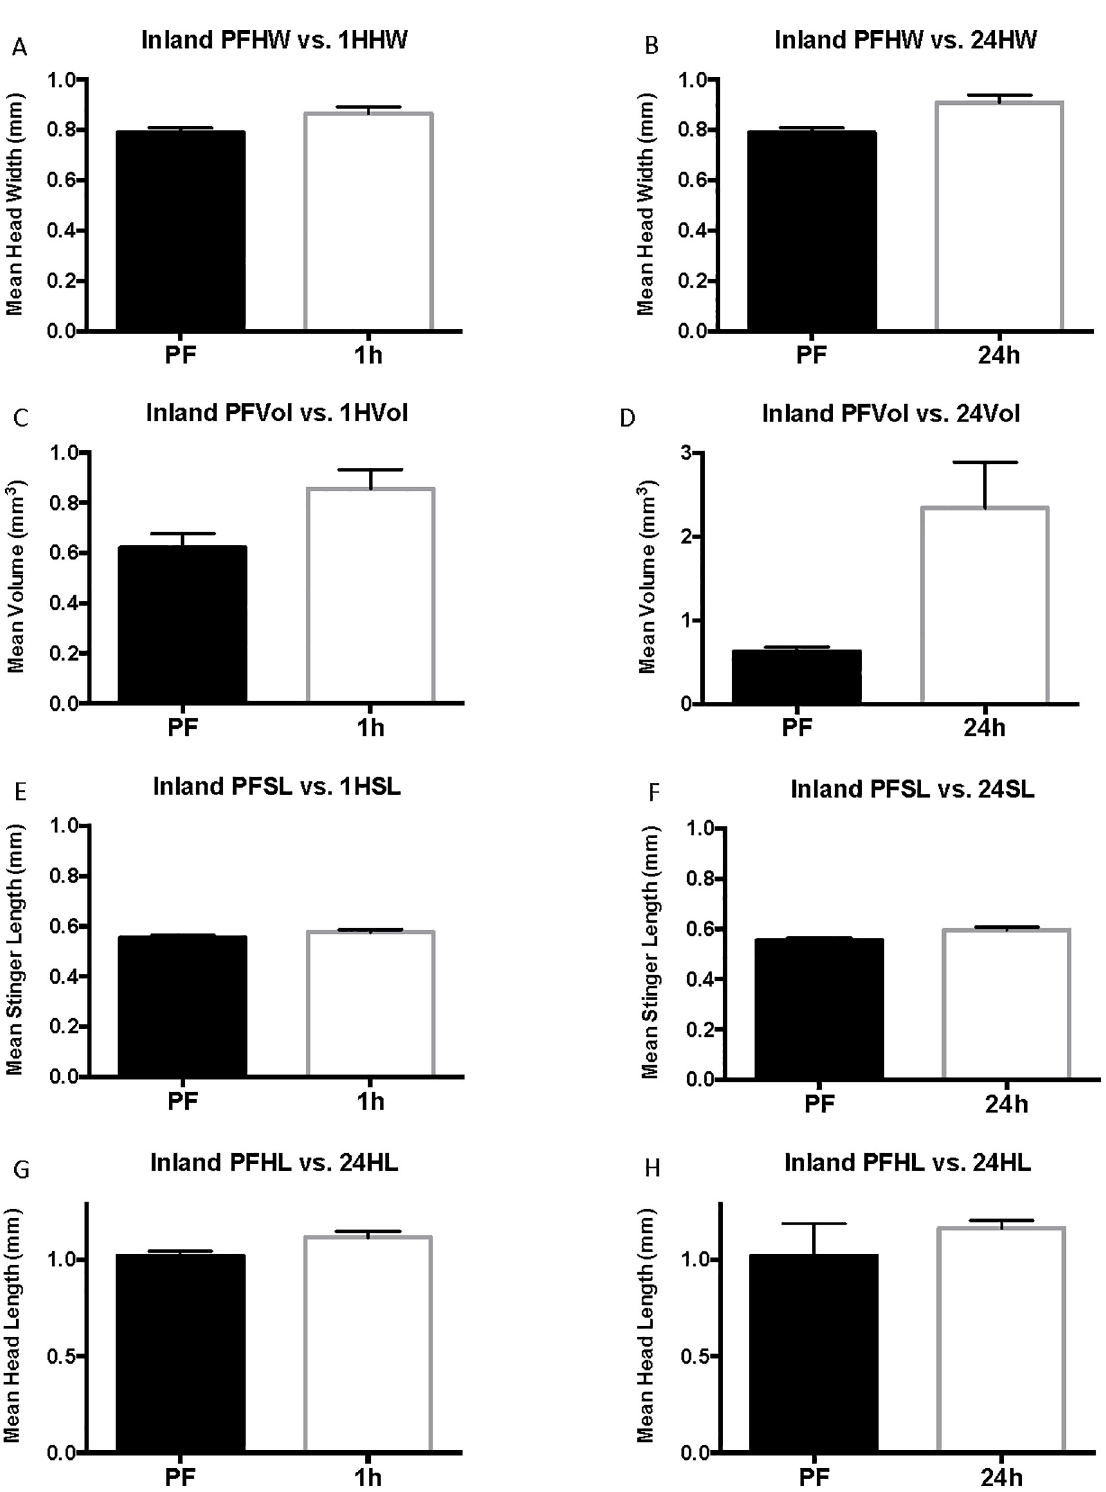
Fig 8. Complete inland results. Mean head width, mean stinger length, and mean head length are reported in mm. Mean volume is in mm 3 . The error bars represent standard error of the mean. PF refers to pre-flood cohorts, 1H refers to 1-hour cohorts, and 24h refers to 24-hour